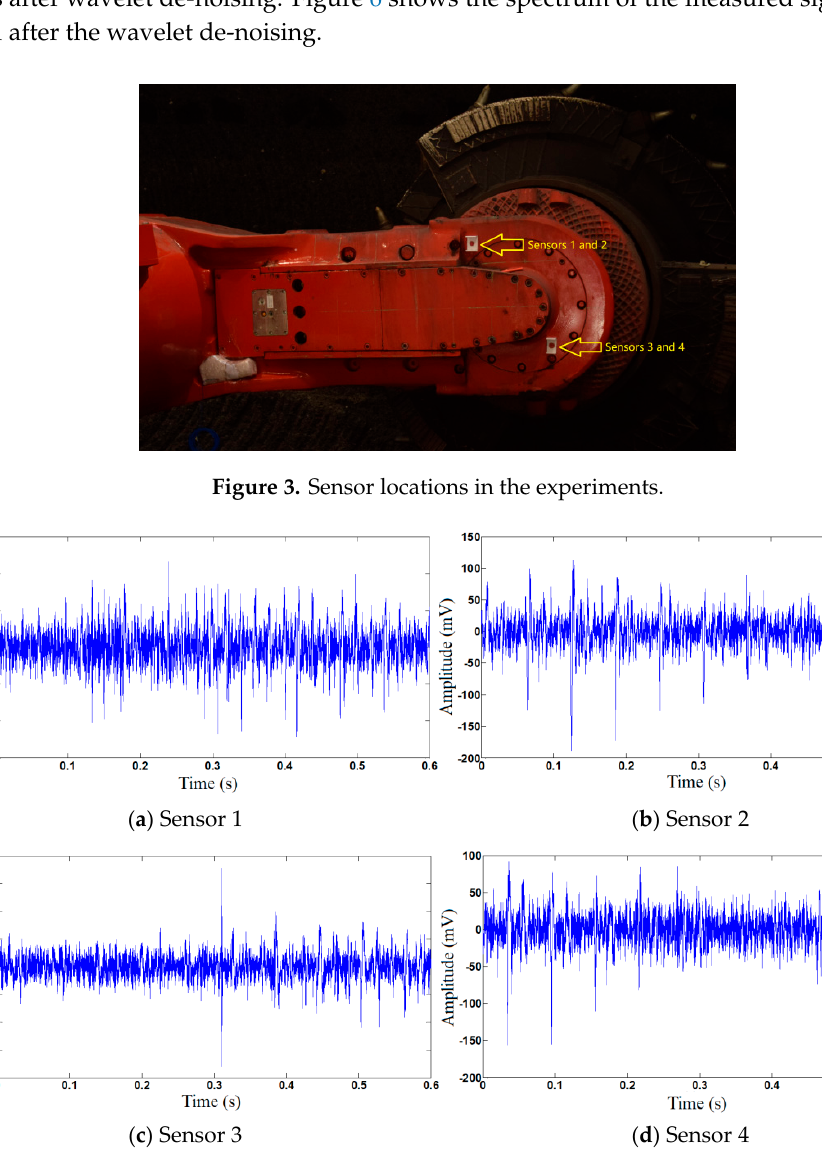
Figure 4. Time waveforms of measured vibration signals of the four sensors.